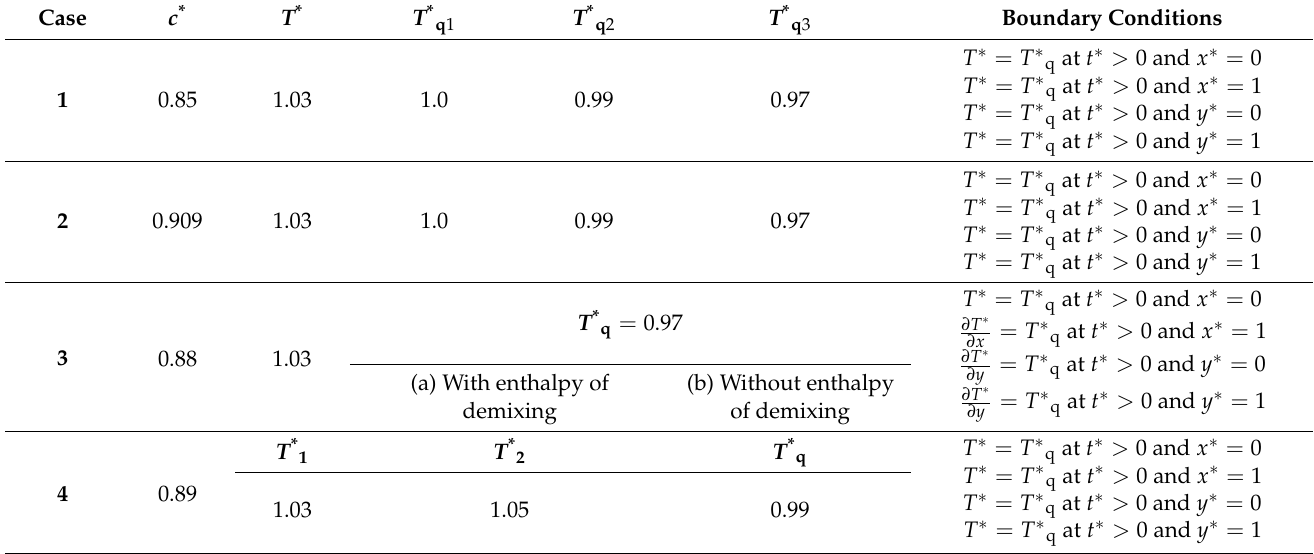
Figure 1. Schematic phase diagram of the polystyrene-cyclohexanol polymer solution with two degrees of polymerization of N 2 = 10 and N 2 = 100. Table 1. Conditions studied in this paper including boundary condition, quench depths, and initial average concentrations of the